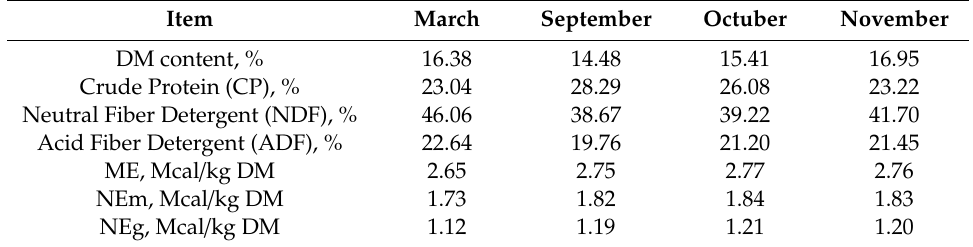
Table 1. Nutritional characteristics of the pasture grazed in the study 1